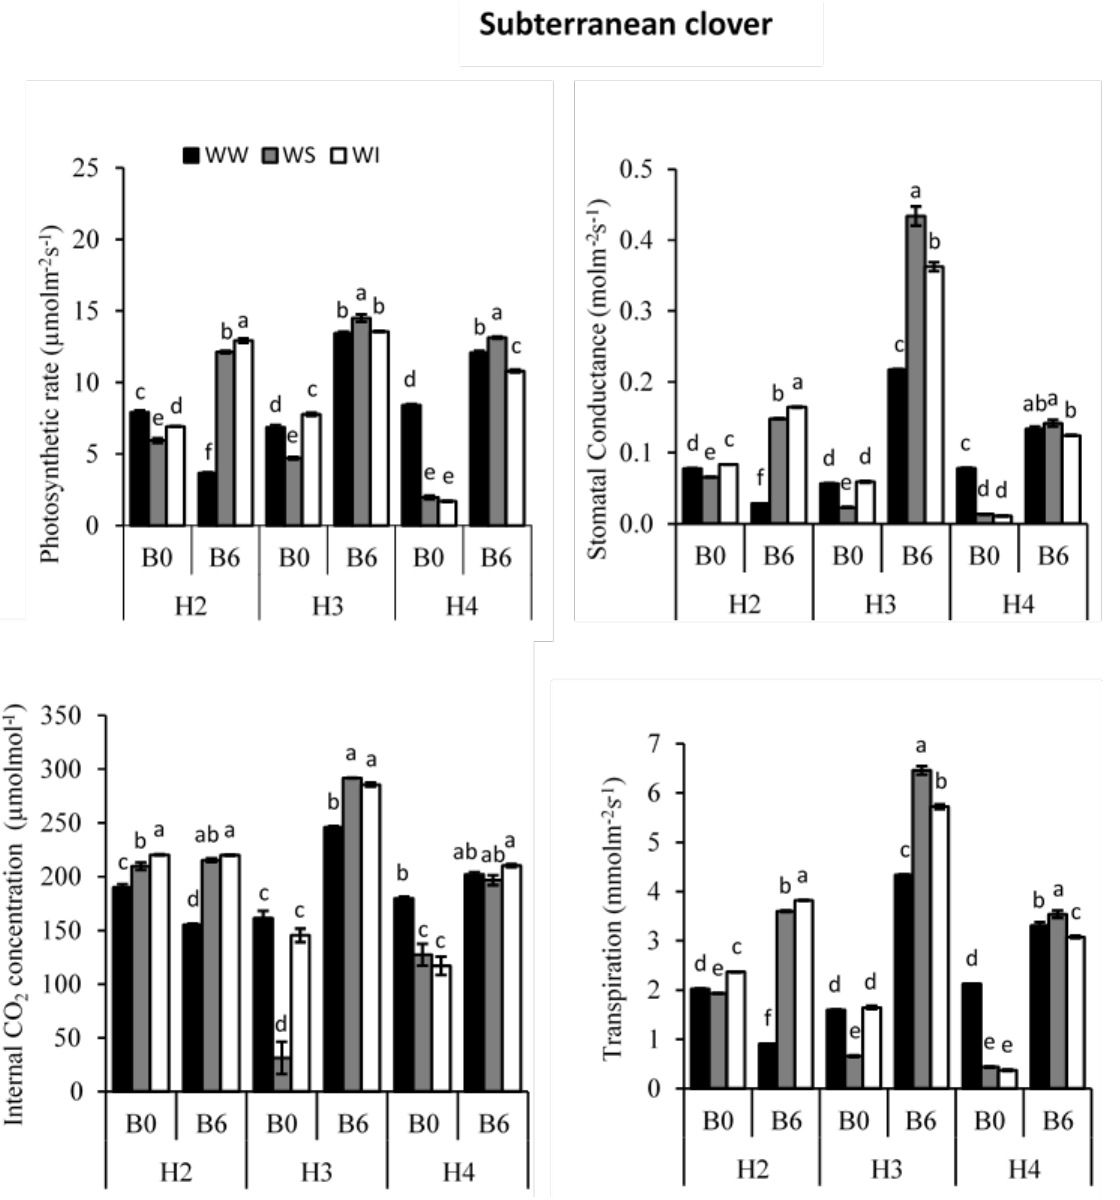
Figure 4. Effect of biochar and water regime on photosynthesis ( µ molm − 2 s − 1 ), stomatal conduc- tance (molm − 2 s − 1 ), internal CO 2 concentration ( µ molmol − 1 ) and Transpiration (mmolm − 2 s − 1 ) of subterranean clover for the well-watered (WW); water-stressed (WS) and water intermittently (WI) treatments; at four harvest times; with 6 t ha − 1 biochar (B6) or without biochar application (B0); different letters on top of columns indicate significant difference between treatments at p < 0.05 in each har- vest.